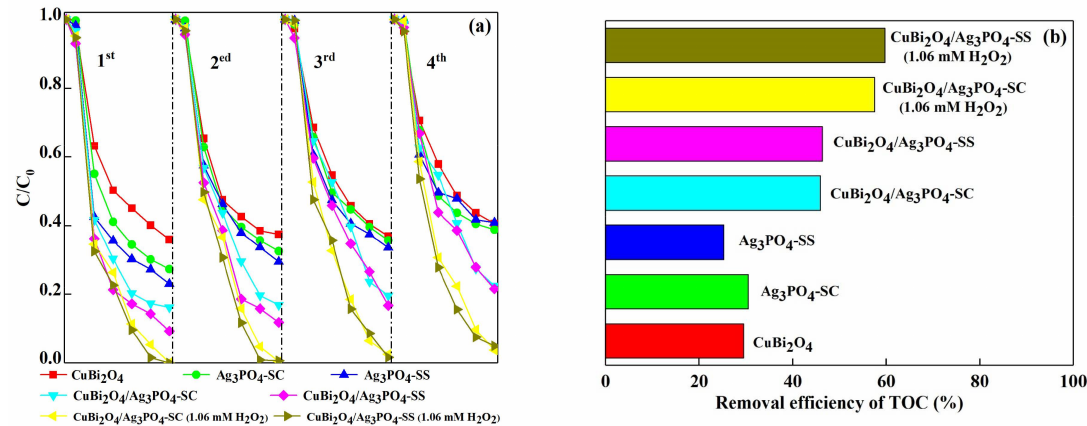
Figure 5. ( a ) Degradation efficiency of DS with different photocatalysts in different recycle runs; ( b ) TOC removal efficiency of the DS solution with four times recycling of